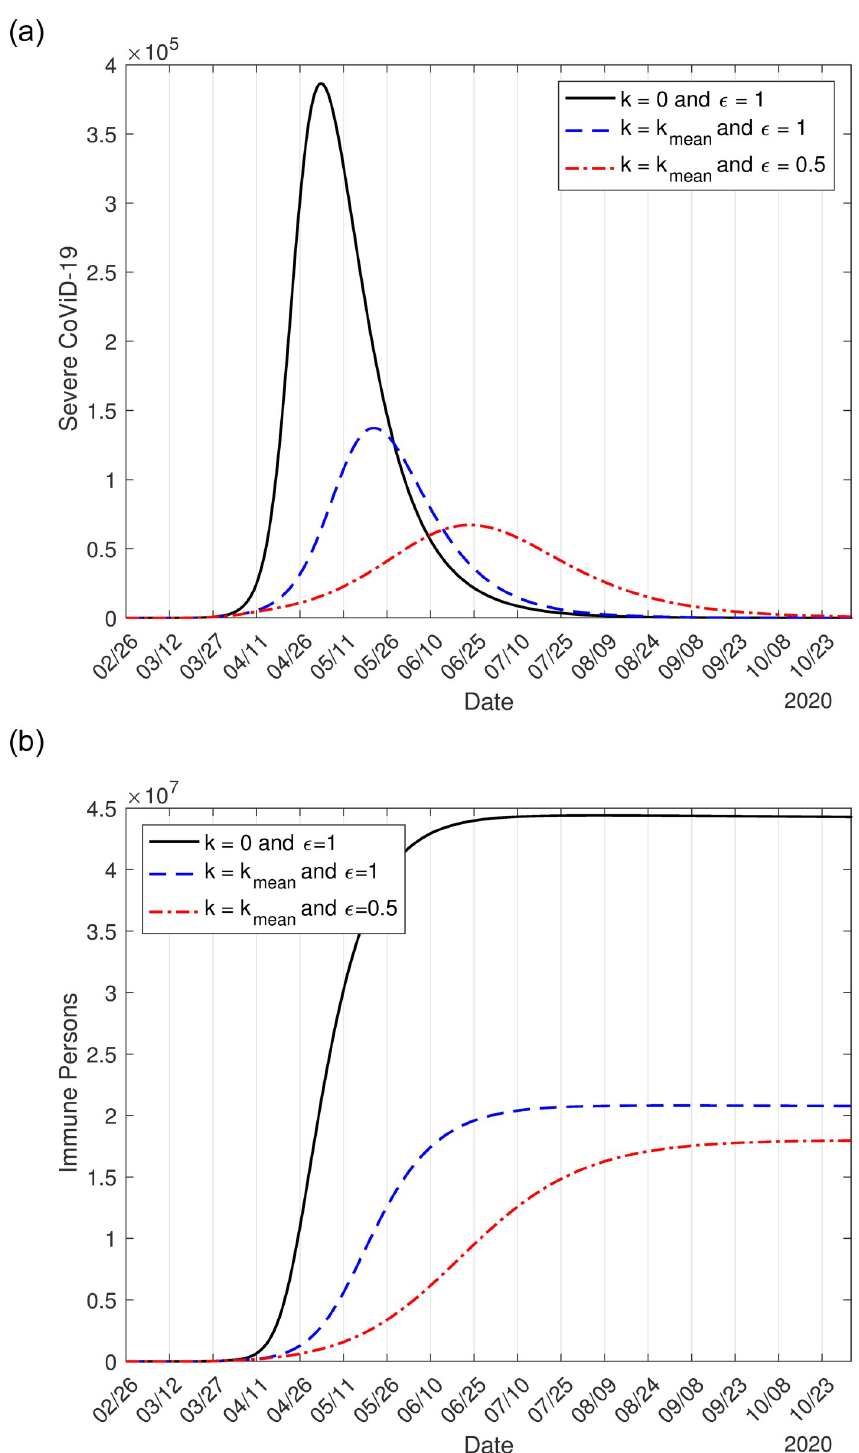
Fig 1. The curves of the natural epidemic ( k = 0 and ε = 1), epidemic considering only isolation ( k = 0.53 and ε = 1), and epidemic occurring with isolation and protective measures ( k = 0.53 and ε = 0.6) (a), and the number of immune persons I